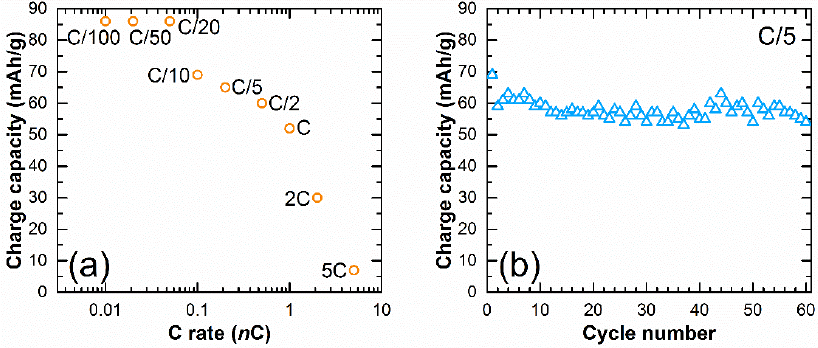
Figure 4. Charge capacity ( a ) vs. C rate and ( b ) vs. cycle number at a rate of C/5 in the range 4.5 – 2.0 V.